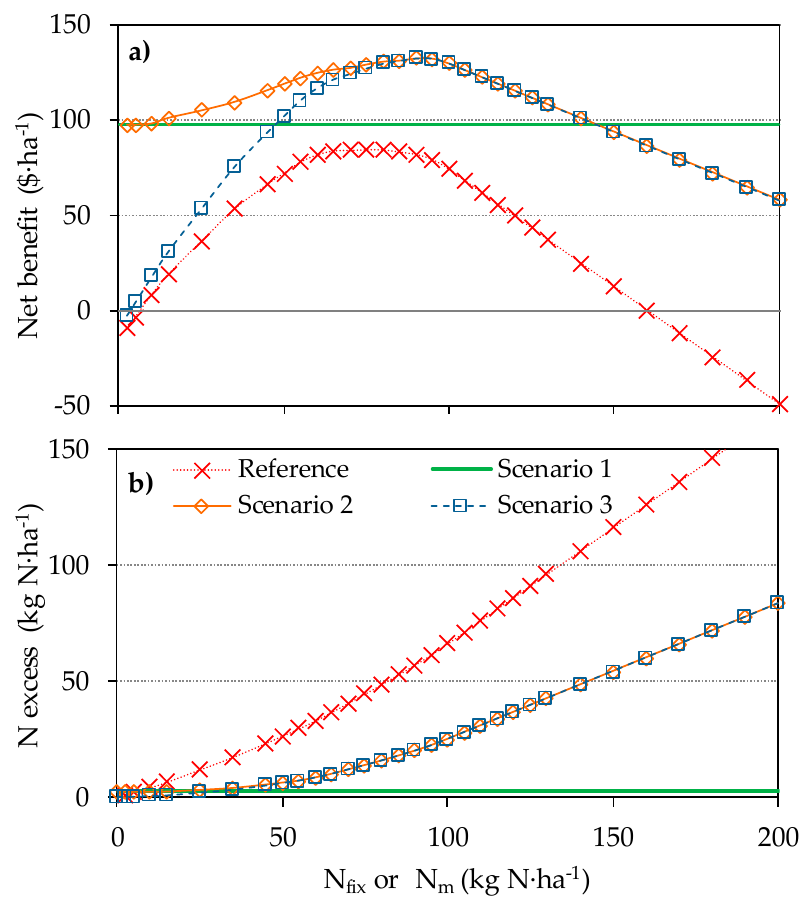
Figure 5. Net benefit ($ · ha − 1 ) ( a ) and N excess (kg N · ha − 1 ) ( b ) according to the fixed predefined N rate (N fix , kg N · ha − 1 ) or minimum N rate (N m , kg N · ha − 1 ). Each point is the average of the 24 plots used in the economic analysis.